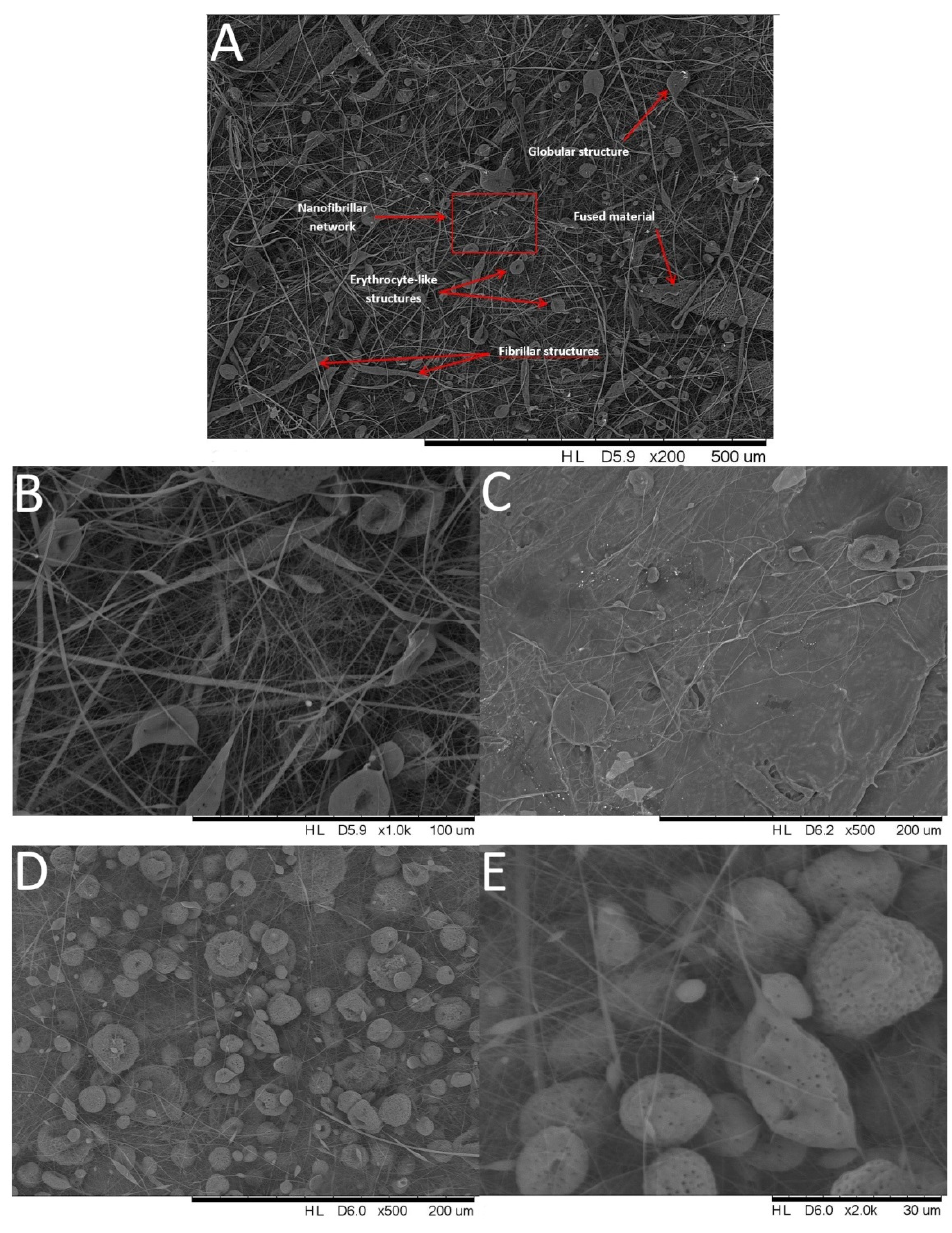
Figure 1. SEM images of the neat PLA electrospun membranes: ( A ) Membrane obtained under conditions (2) with different structures formed being shown; ( B ) A red rectangle section from image ( A ) under higher magnification; ( C ) Foil-like structure obtained under conditions (3); ( D ) Membrane obtained under conditions (4); ( E ) A section from image ( D ) under higher magnification.